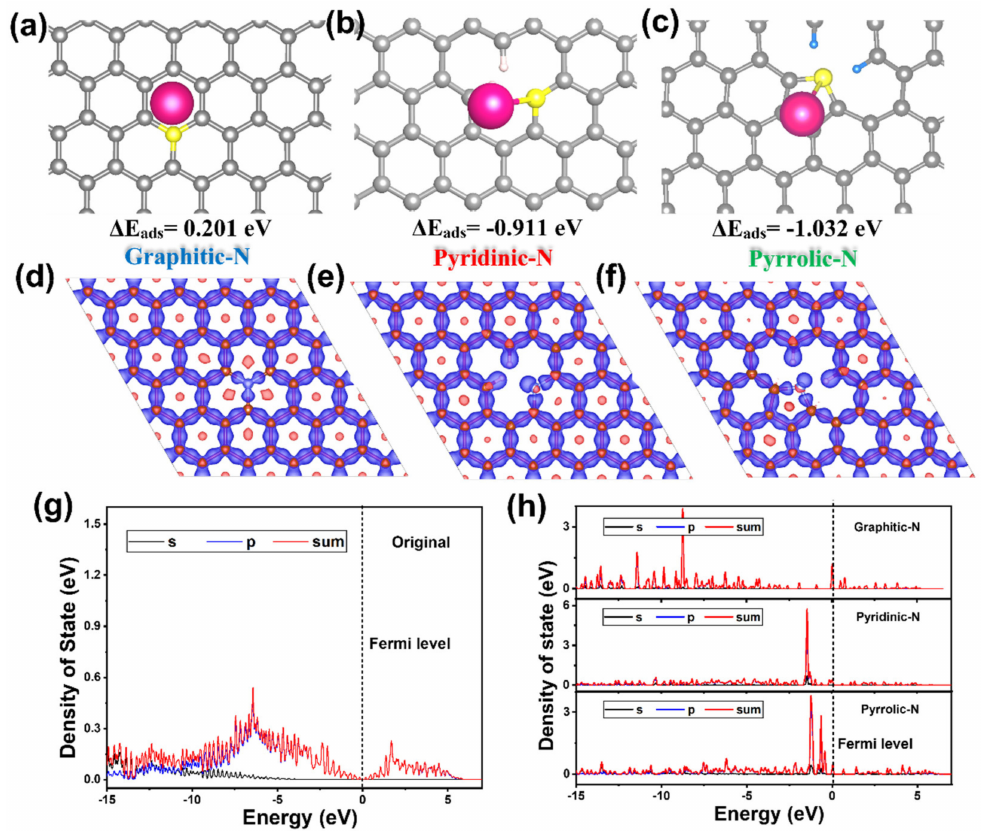
Figure 4. The DFT illustrations of adsorption energy of K ions (set adsorption energy at original hard carbon as 0 eV) and differential charge densities in ( a , d ) graphitic-N, ( b , e ) pyrindic-N, and ( c , f ) pyrrolic-N defects. The density states of ( g ) original hard carbon and ( h ) various defects of N − doping hard − carbon